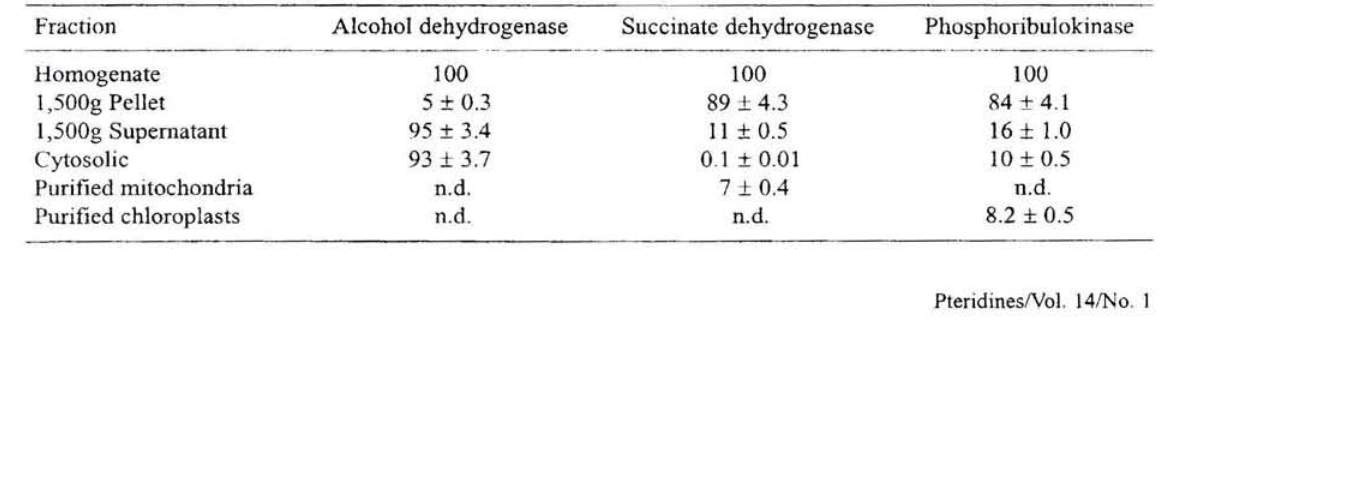
Table 3 Distribution of marker enzymes in subcellular fractions Pea leaves yvere extracted as in Table 2 and each fraction was treated with 0.1% (v/v) Triton X-100 prior to assay ofthe marker enzyme activity (see Materials and Methods). Data expressed as % of total enzyme activity recovered, means +SEM, n = 12. n.d. — Not